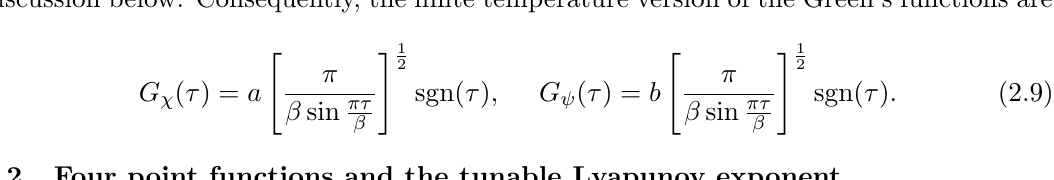
Figure 2 . (a). Three contributions of K R;(cid:31)(cid:31) ( t 1 : : : t 4 ). The (cid:12)rst two diagrams are of order 1 the third one is of order 1 . (b). Diagrammatic representation of the self consistency equation N 2 eq.